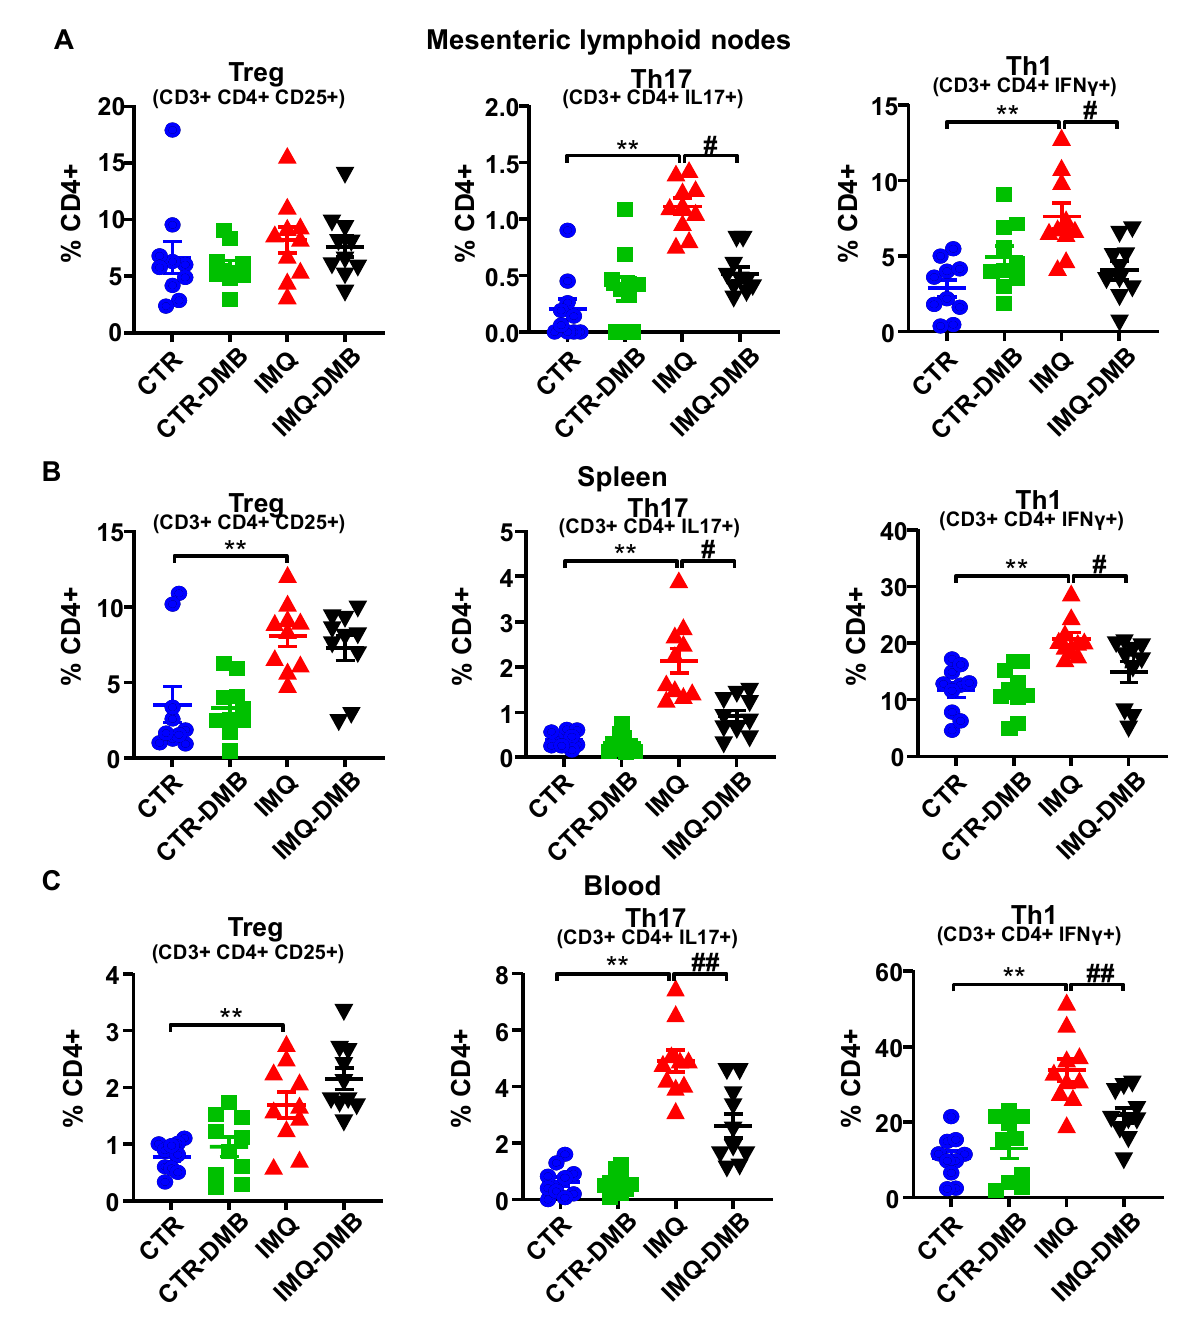
Figure 4. TMAO facilitated lymphocyte activation and proliferation in imiquimod (IMQ) animals. ( A ) Regulatory T (Treg), Th17, and Th1 cells as analyzed through flow cytometry in mesenteric lymph nodes, ( B ) in spleen, and ( C ) blood in CTR, CTR-group treated with DMB (CTR-DMB), IMQ, and IMQ-group treated with DMB (IMQ-DMB). Data are represented as means ± SEM. One-way ANOVA and Tukey’s post hoc test or Kruskal–Wallis test with Dunn’s multiple comparisons were performed. ** p < 0.01 compared to CTR; # p < 0.05 and ## p < 0.01 compared to